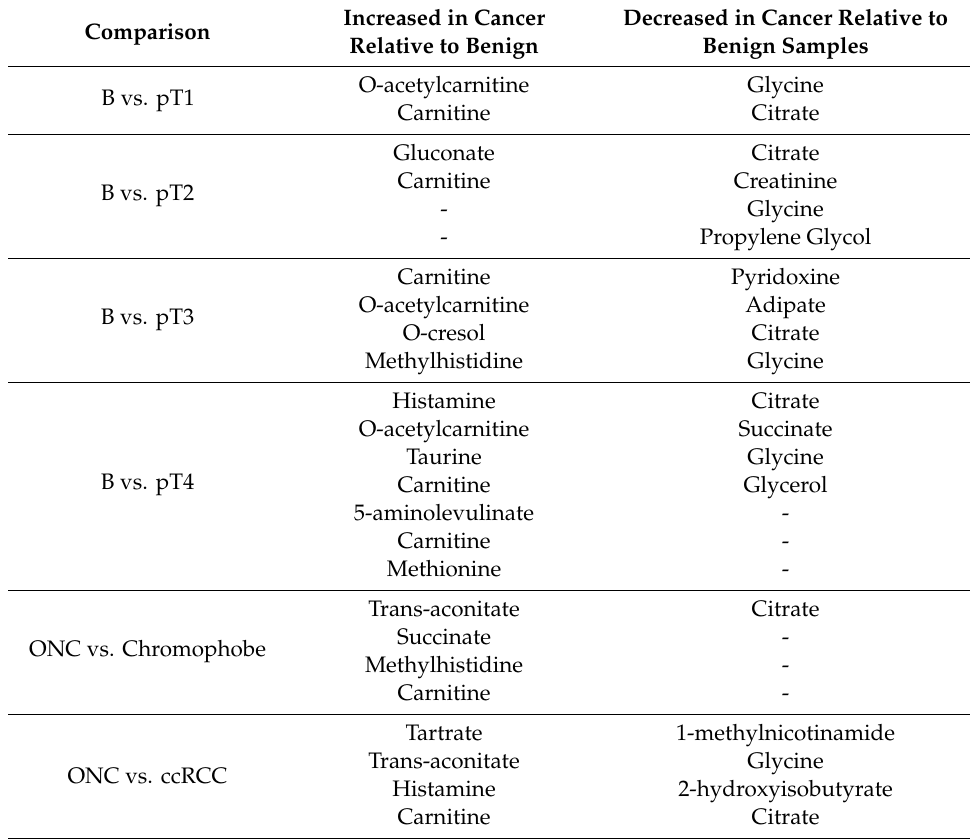
Table 3. Di ff erential metabolites linked to renal cell carcinoma in 1 H NMR analysis of